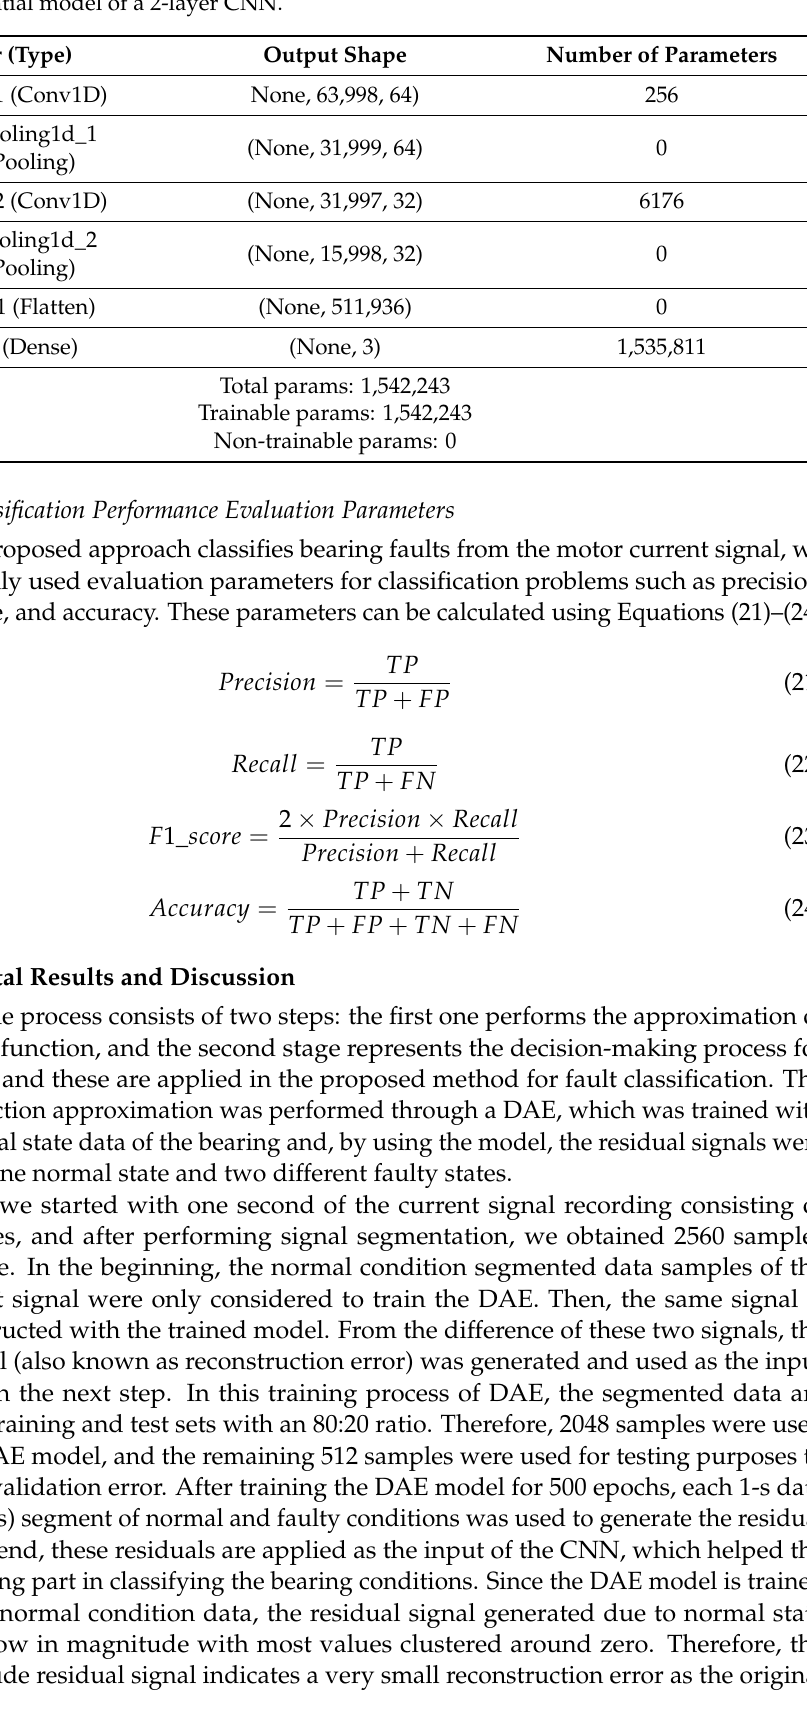
Table 4. Sequential model of a 2-layer